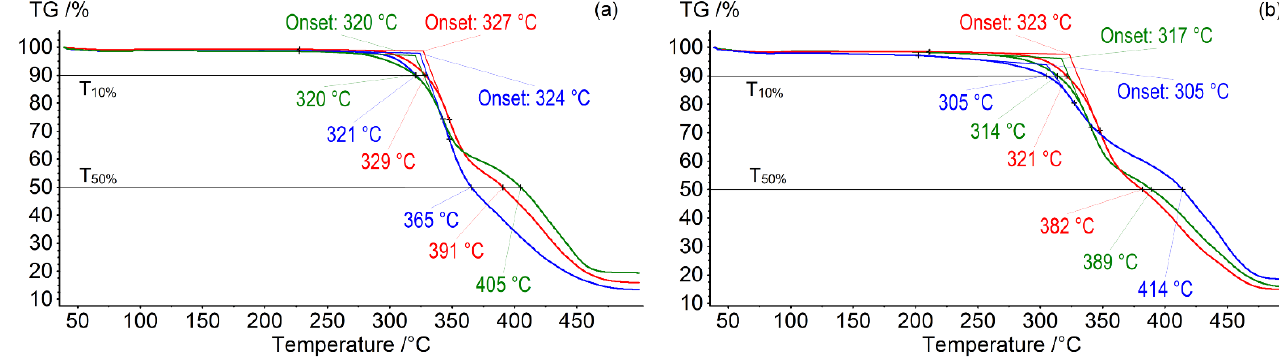
Figure 1. TG curves of the compounds with Gly: ( a ) 16 (green), 18 (blue), 20 (red), and L -Phe: ( b ) 17 (green), 19 (blue), 21 (red) fragments (dynamic argon atmosphere of 75 mL/min in the temperature range from 40 to 500 °C).